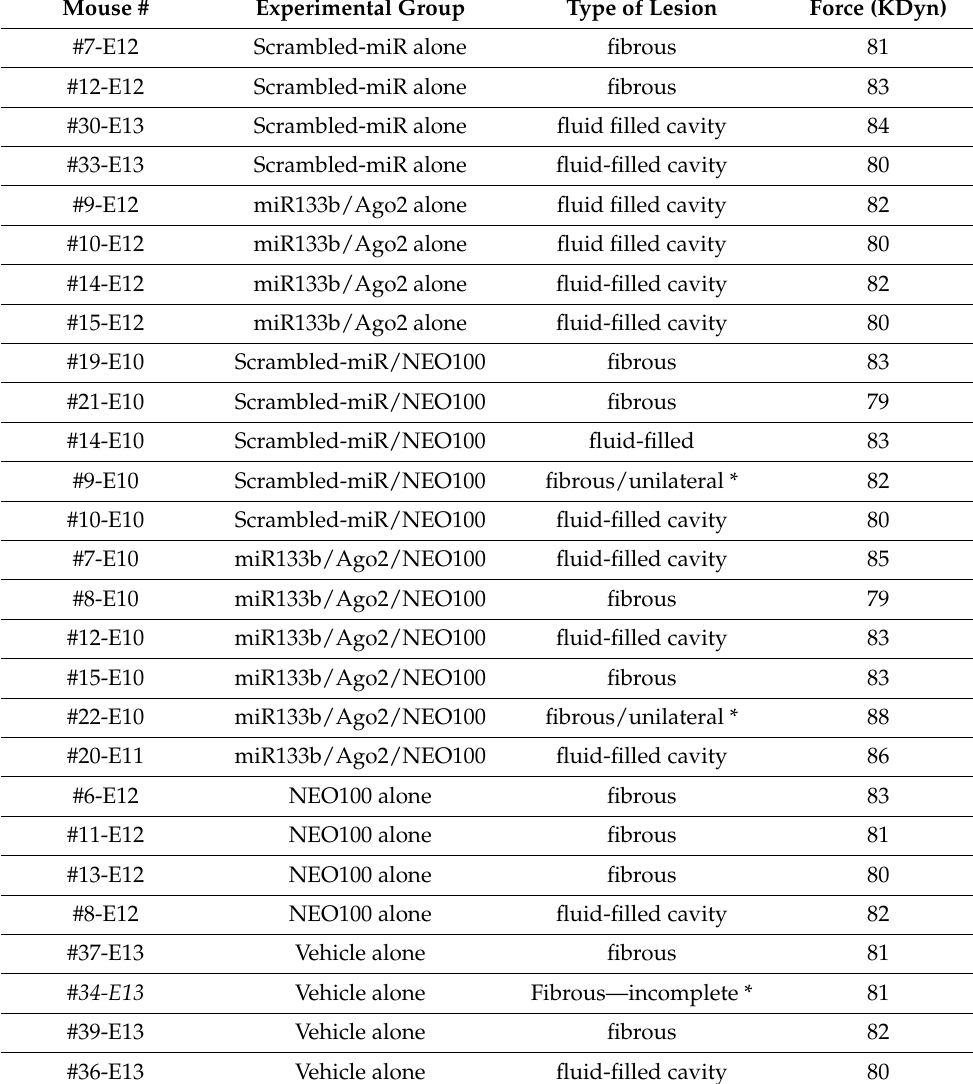
Table 1. A comprehensive description of the spinal cord injury conditions and lesion types for mice involved in behavior and histology analysis